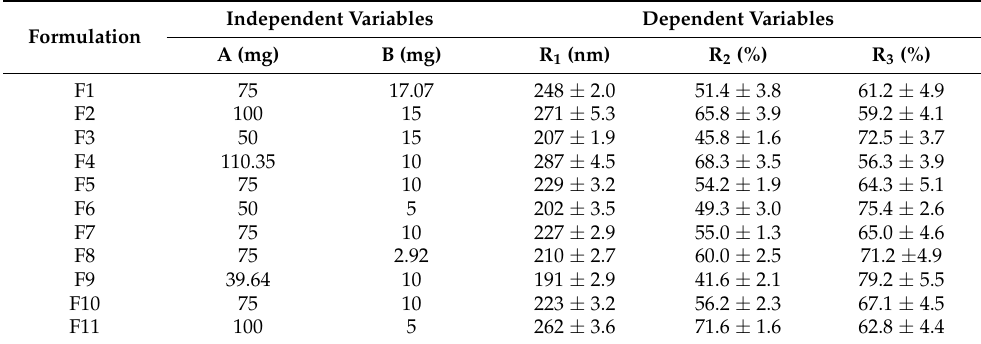
Table 1. The independent variables used for optimizing different PEGylated liposomal formulations and the detected dependent variables.